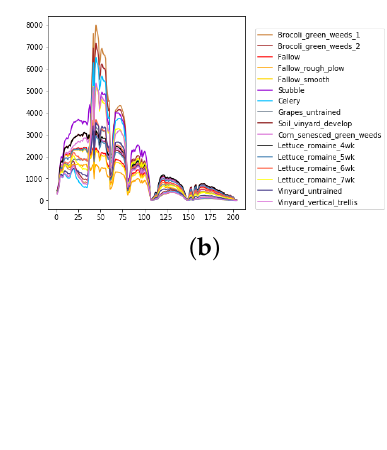
Figure 7. ( a ) False-color University of Pavia image. ( b ) Ground-truth map of the University of Pavia data set.